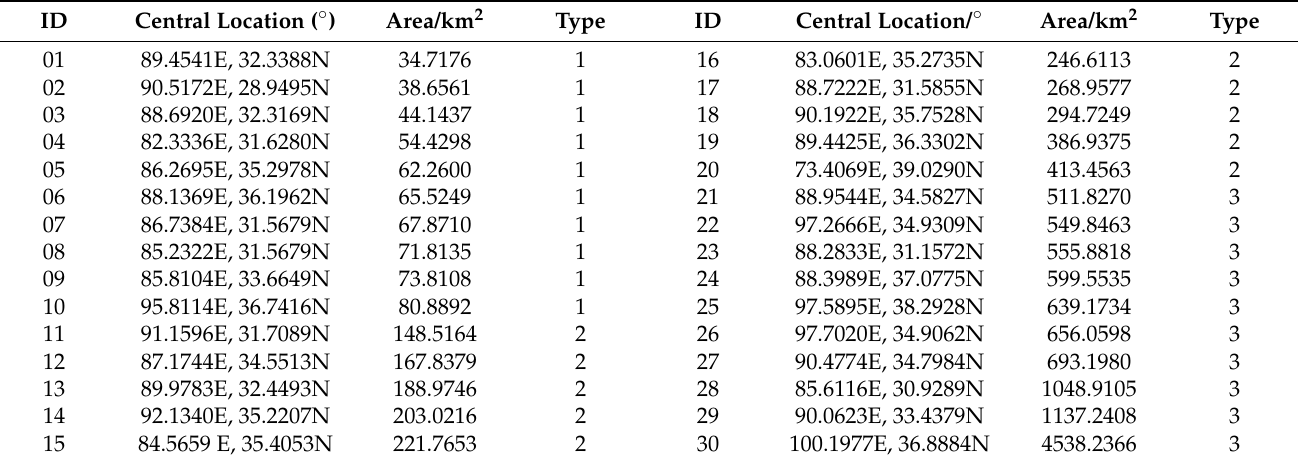
Table 4. Extraction results of lake waterbody area by different